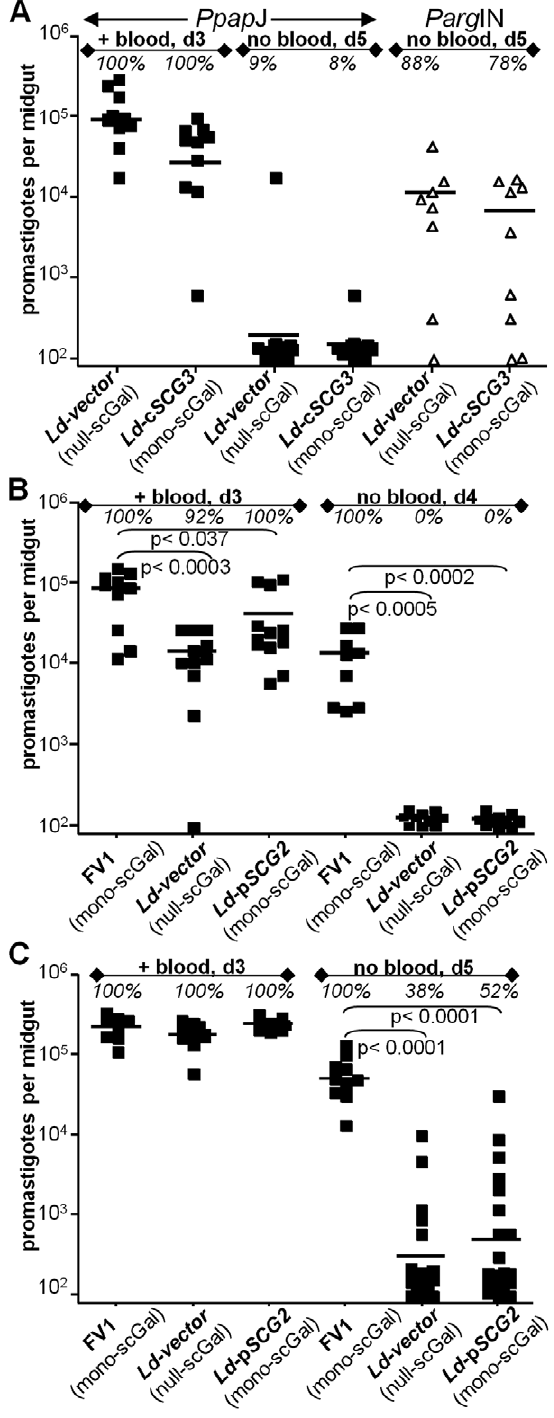
Figure 4. Expression of ‘‘ Ppap J-optimal’’ scGal-LPG PAMPs in L. donovani-SCG transfectants does not improve survival in Ppap J sand flies. Female sand flies were membrane fed on the indicated Leishmania -infective mouse blood and the number of viable parasites per midgut determined on the indicated day post-feeding as described in Fig. 1. Ld transfectant lines are described in the text, with additional data in Table S1. In panel A, P. papatasi Ppap J (‘‘ Ppap J’’) and P. argentipes Parg IN (‘‘ Parg IN’’) flies fed on infective blood containing 10 6 10 6 parasites per ml. In separate experiments, P. papatasi Ppap J flies fed on infective blood containing 5 6 10 6 (panel B) or 20 6 10 6 (panel C) parasites per ml.